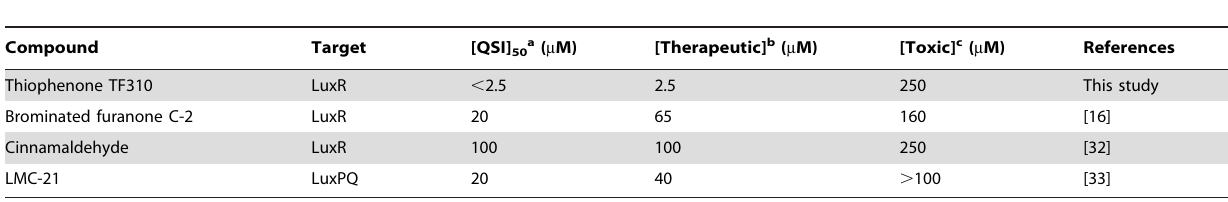
Table 2. Comparison of the therapeutic potential of different quorum sensing-disrupting compounds in the gnotobiotic brine shrimp - V. harveyi